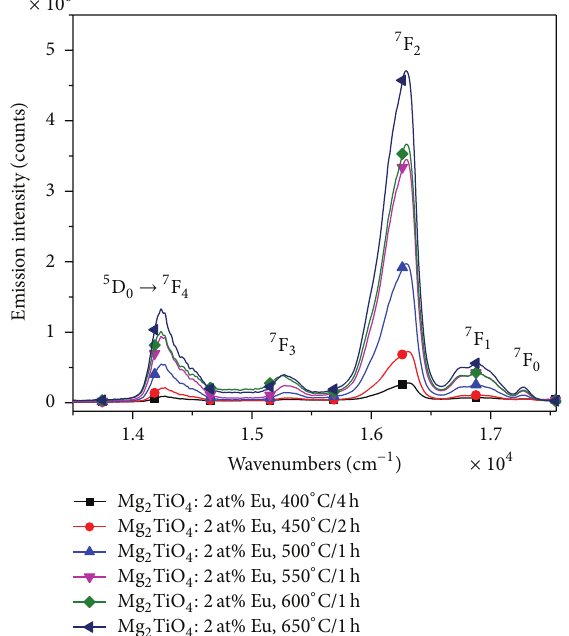
Figure 2: TEM image of the Eu 3+ activated Mg 2 TiO 4 nanoparticles prepared at 600 ∘ C.